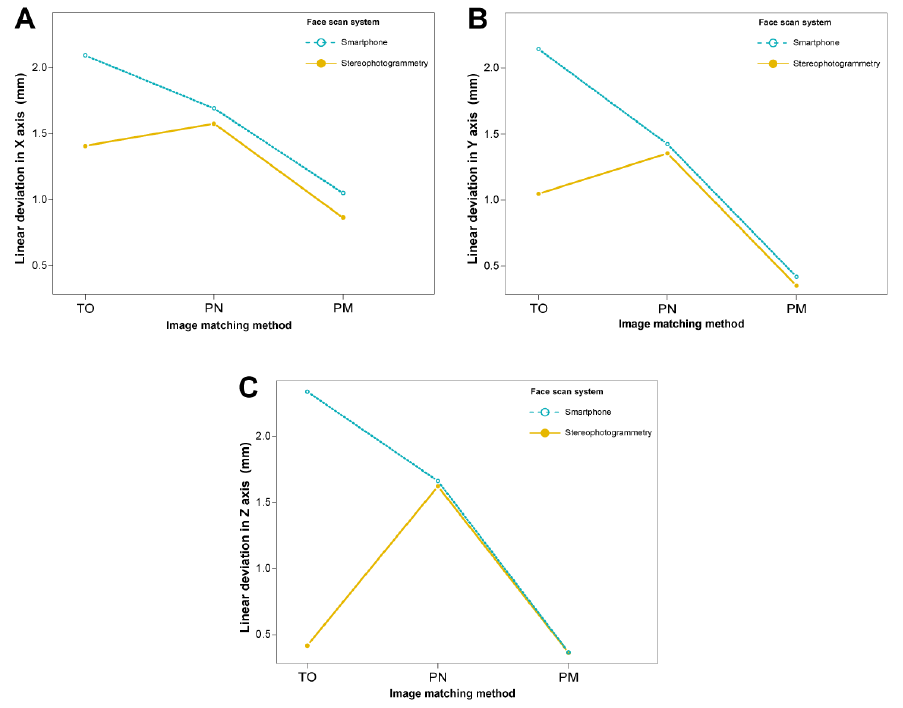
Figure 7. Linear deviations in the image registration of intraoral scan to facial scan. ( A ) in X-axis; ( B ) in Y-axis; ( C ) in Z-axis. TO, teeth image only; PN, perioral image without marker; PM, perioral image with markers.